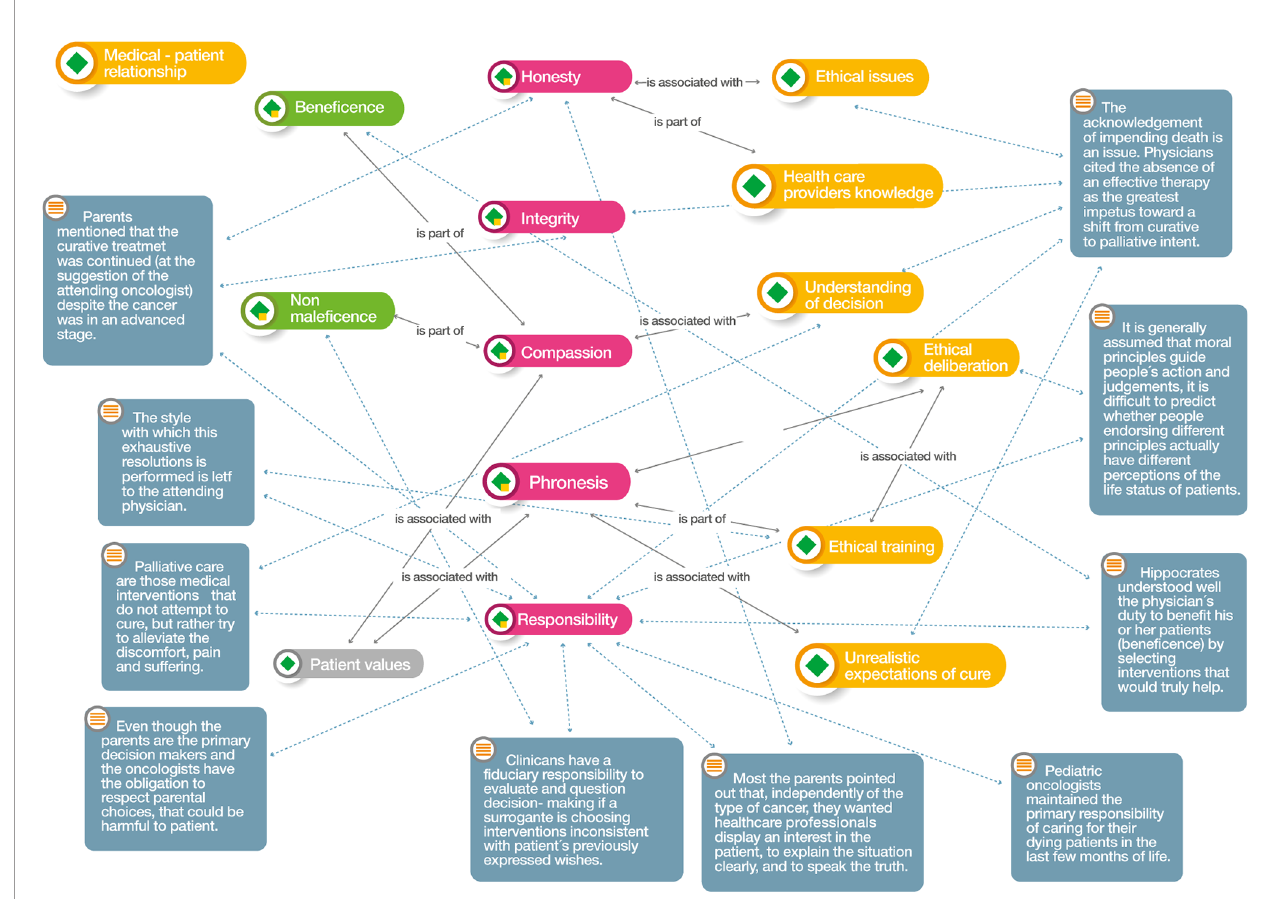
FIGURE 4 | Atlas.ti v.9 ® Foundational values network. Color codes Groups: Red: Medical virtues; Yellow: Medical factors that in fl uence decisions; Dark green: Biomedical ethics principles; Grey: Patients factors for